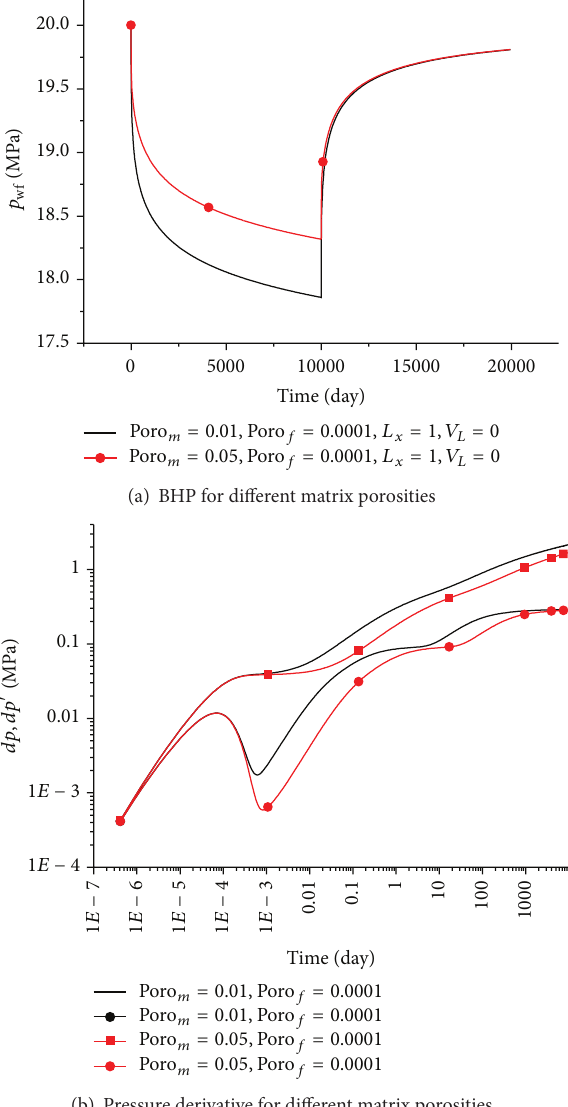
Figure 8: Effect of matrix porosities on pressure response with 𝑉 𝐿 = = 1 m, and 𝜑 = 0.0001 . Figure 9: Effect of matrix porosities on pressure response with 𝑉 0.05 m 3 / Kg, 𝐿 𝑥 𝑓